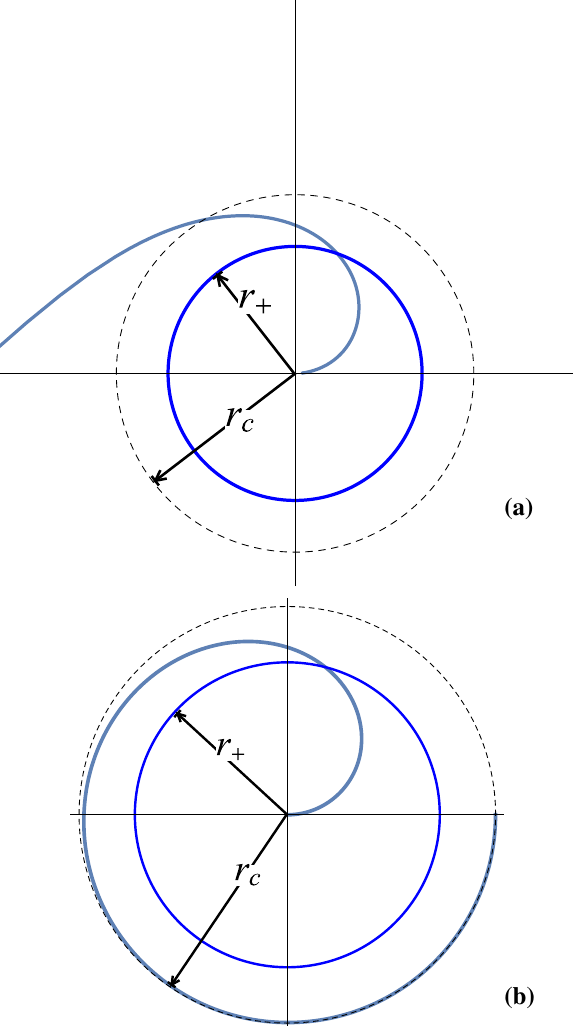
Fig. 5 The capturing process for particles possessing b ≤ b c . The figures indicate approaching particles with a b < b c and b b = b c